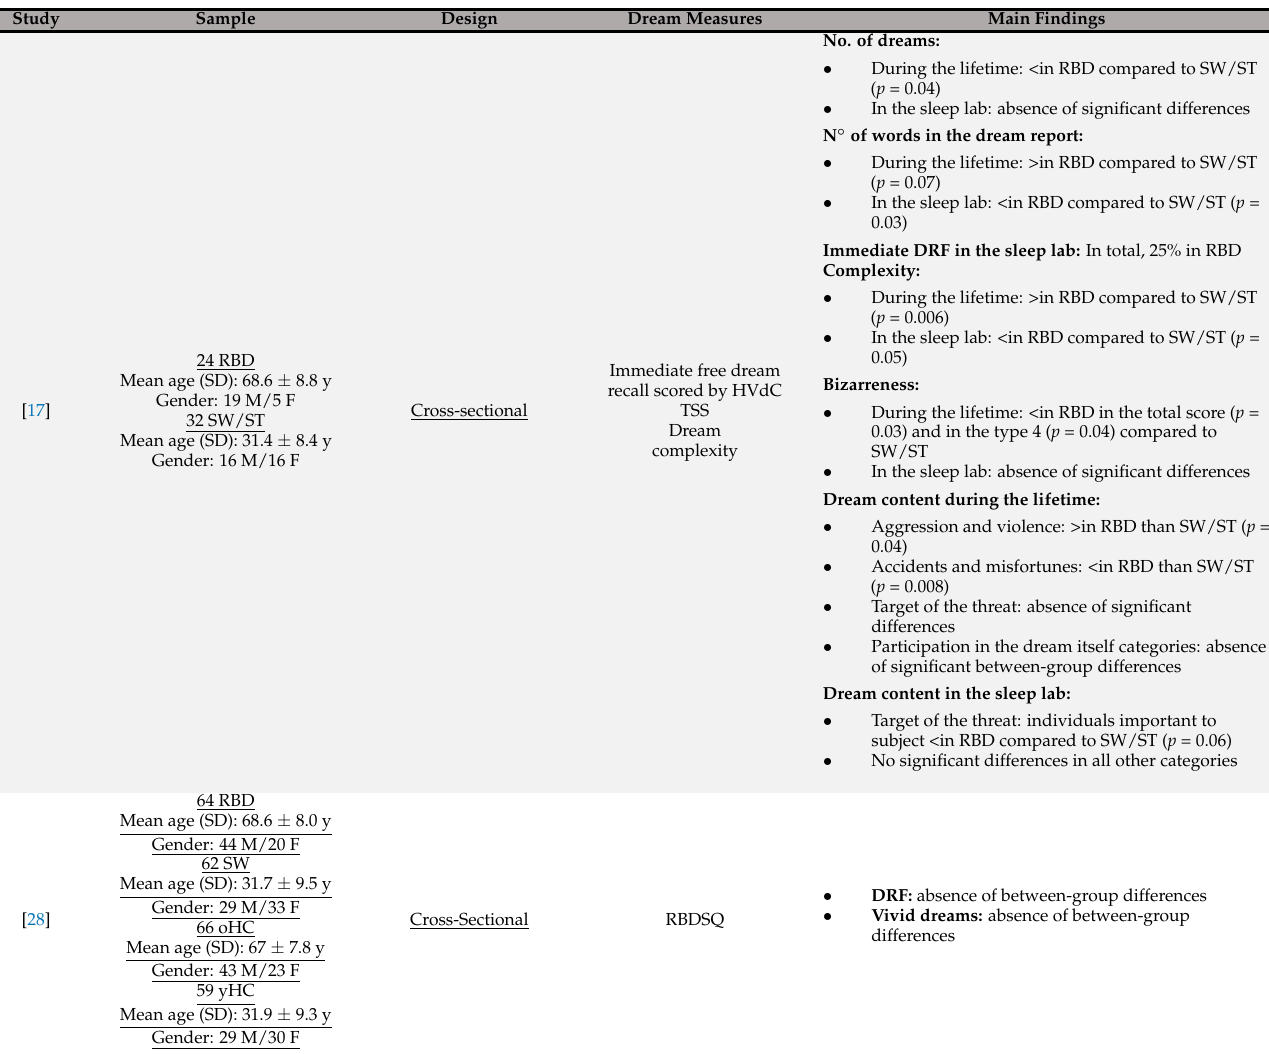
Table 3. Sample, design, tools, and findings in studies investigating dreaming in RBD and other sleep